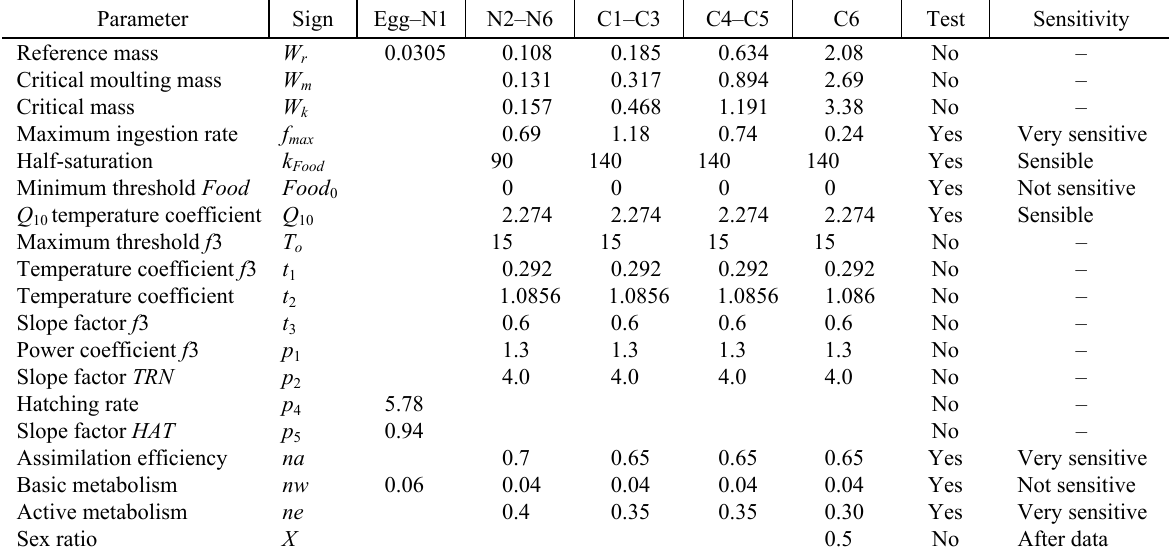
Table 2. Parameter values for Temora longicornis in the model and their level of sensitivity (N, nauplii, C, copepodites); – no result